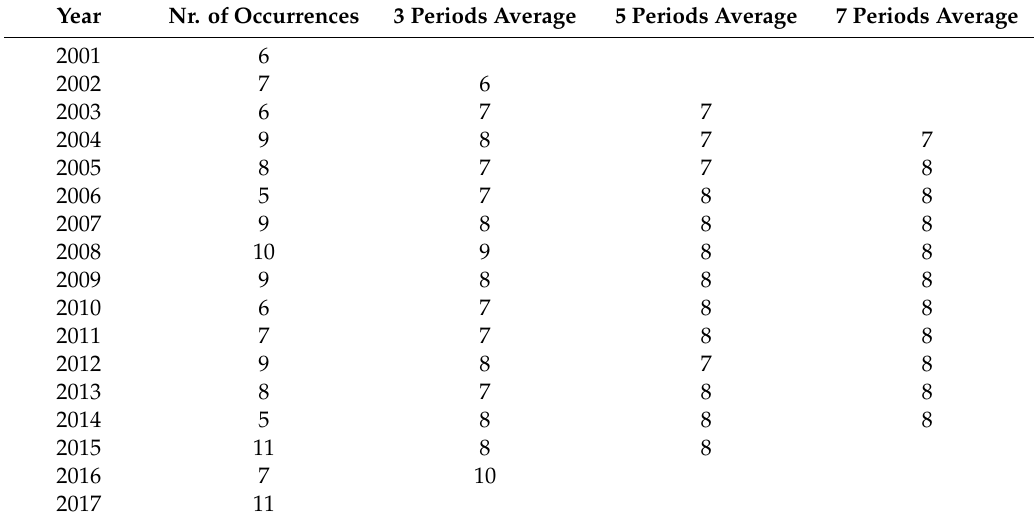
Table 6. Results obtained from the application of the simple moving average method. Year Nr. of Occurrences 3 Periods Average 5 Periods Average 7 Periods